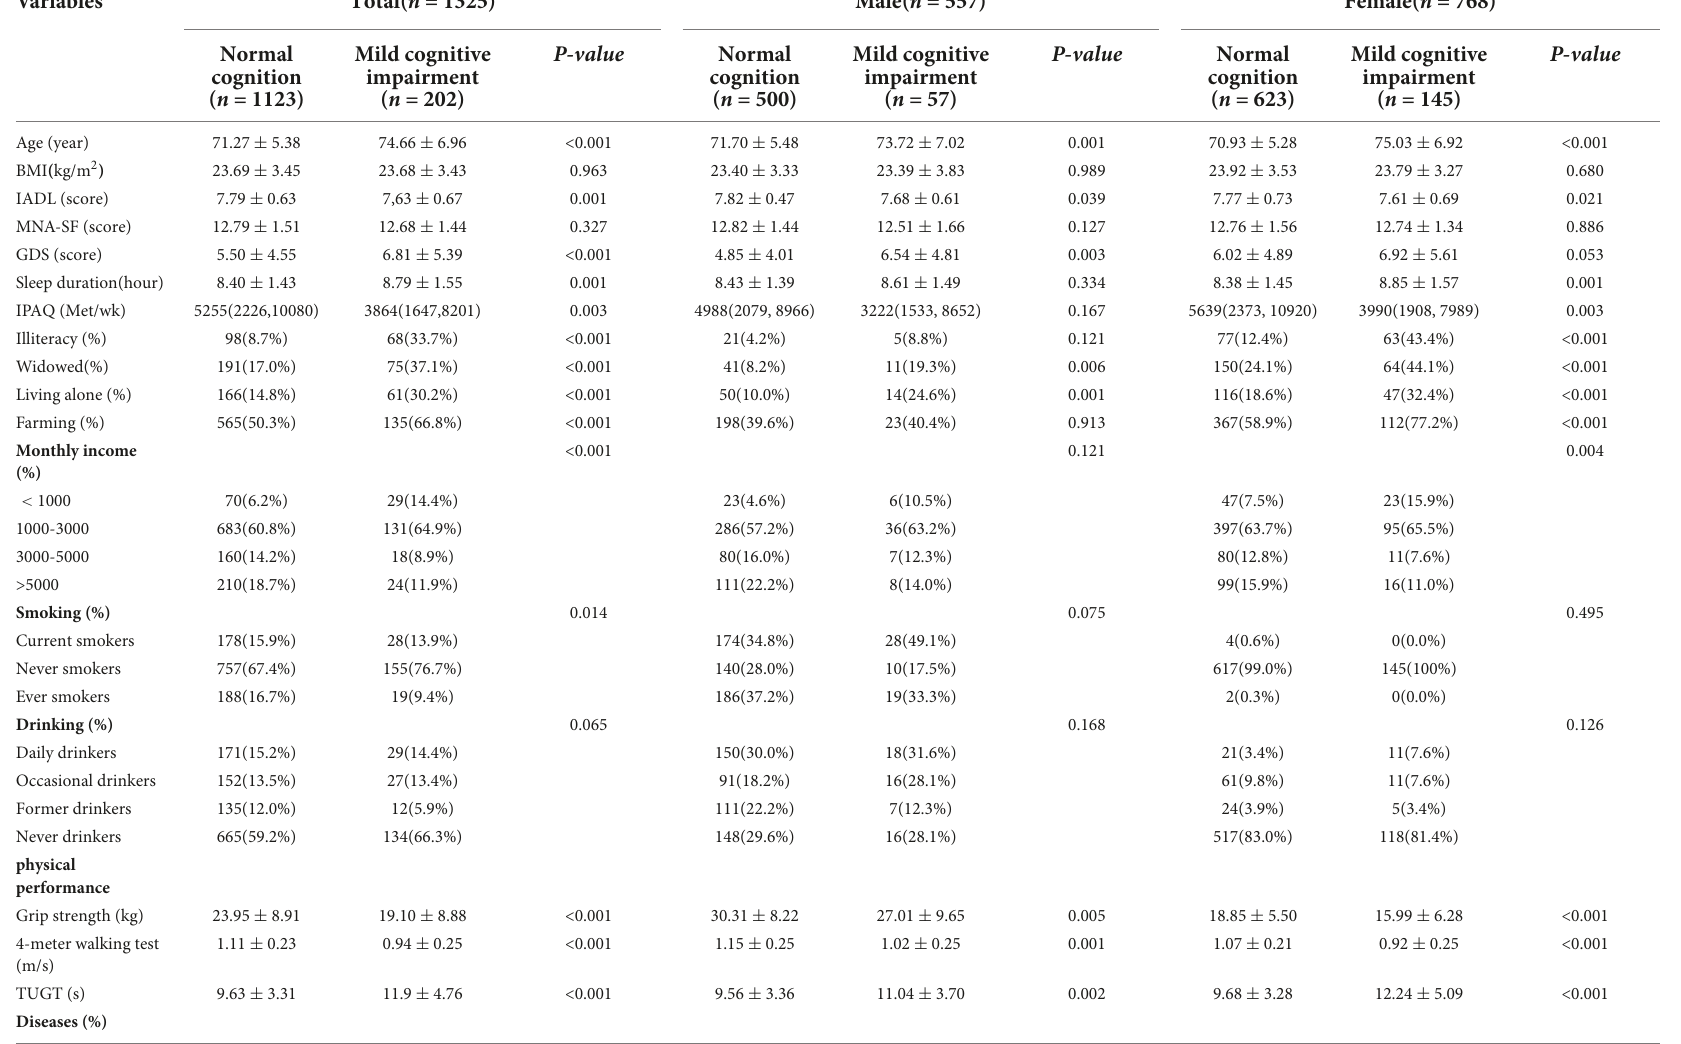
TABLE 1 Baseline characteristics of study participants with normal cognition vs. mild cognitive